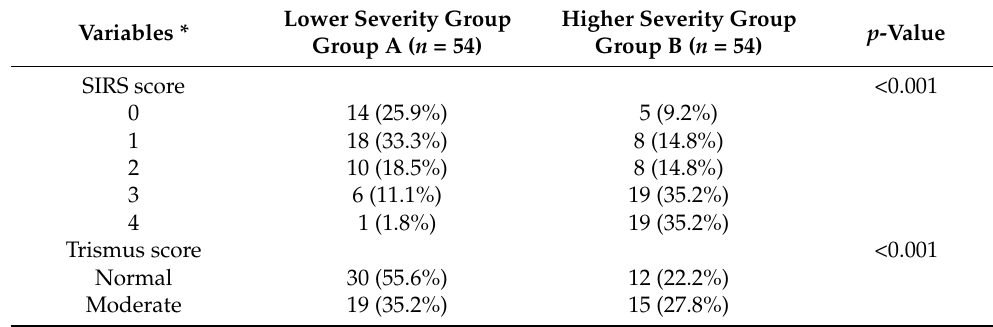
Table 4. Comparison of severity scores among patients with odontogenic